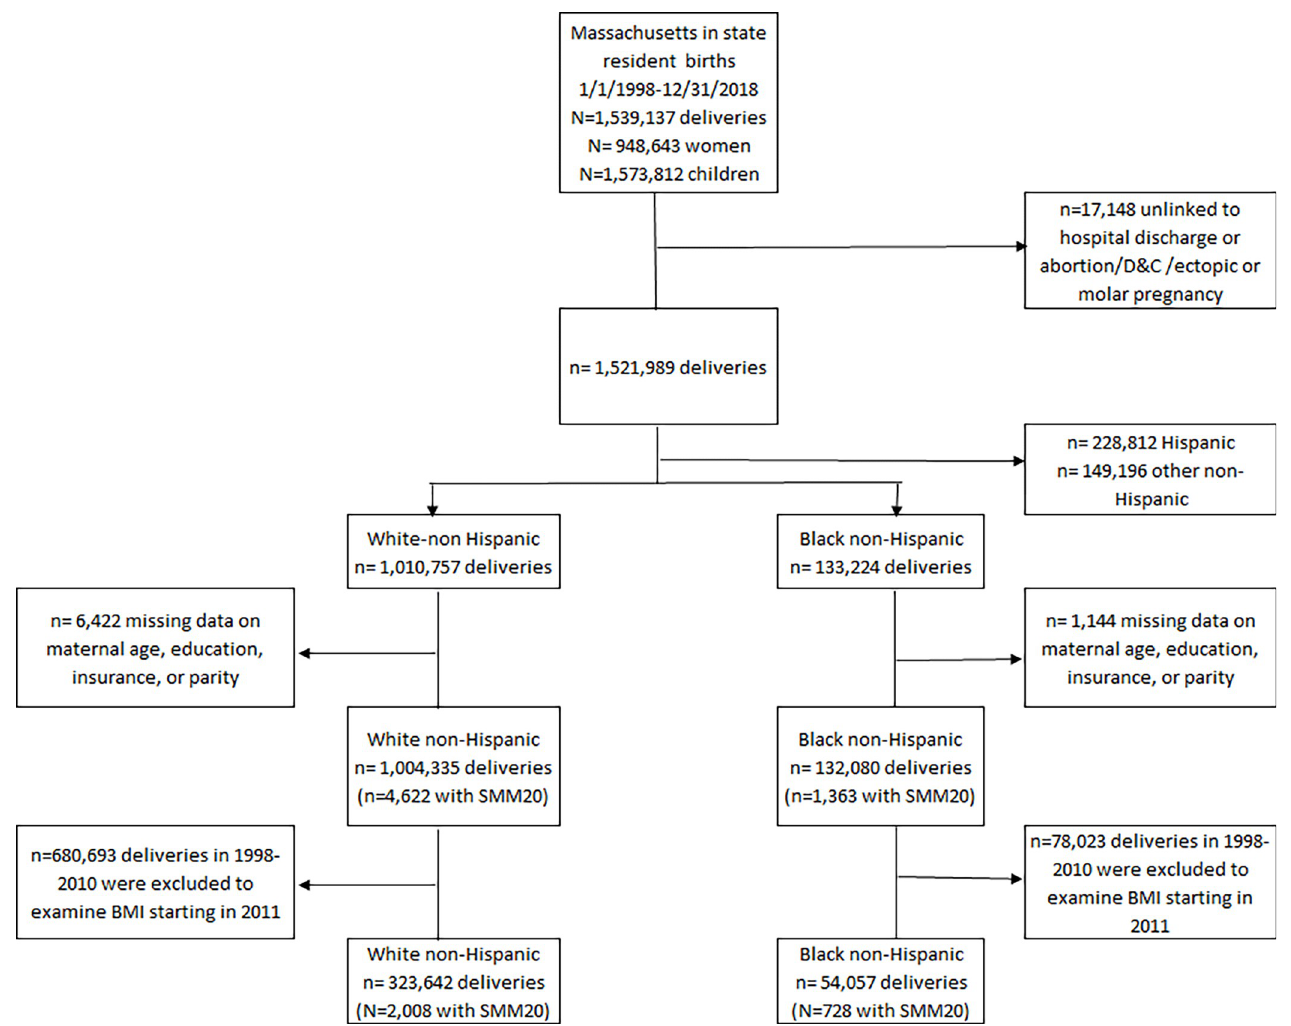
Fig 1. Flow diagram of study sample with inclusion and exclusion